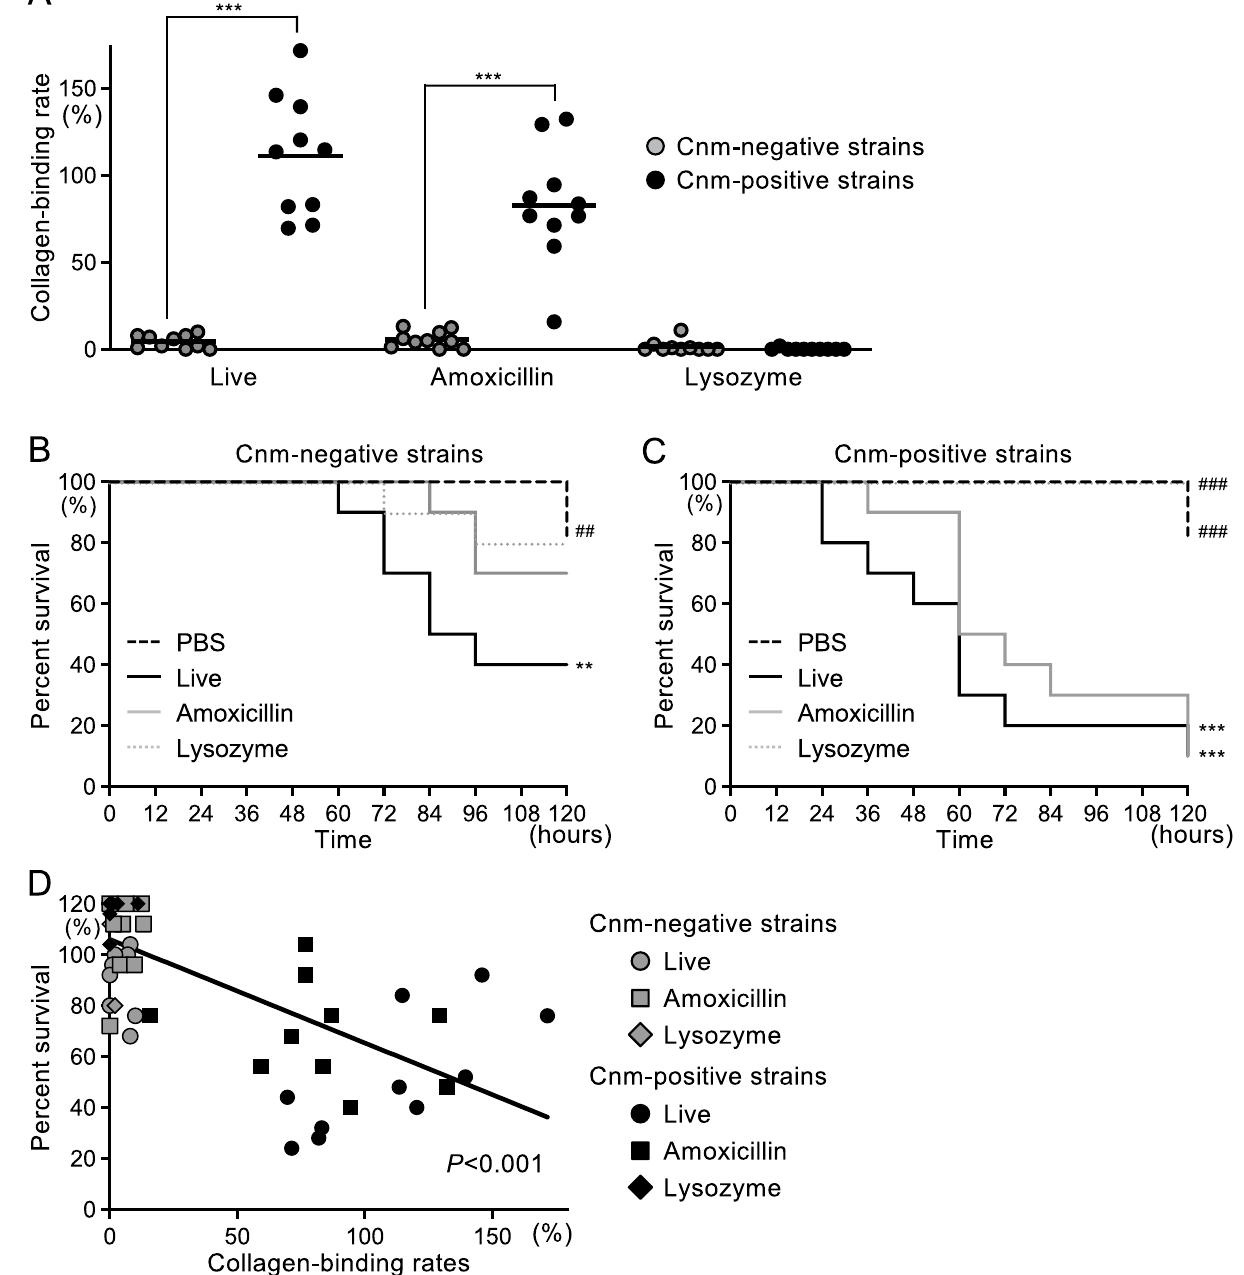
Figure 6. Collagen-binding properties and survival curve for silkworm larvae induced by live S. mutans clinical isolates and killed S. mutans clinical isolates (treated with amoxicillin or lysozyme). ( A ) Collagen-binding rates of S. mutans strains. Each closed circle represents the mean value for each bacterial strain. Significant differences were observed using analysis of variance with Bonferroni correction (*** P < 0.001). Silkworm larvae infected with ( B ) Cnm-negative clinical isolates, and ( C ) Cnm-positive clinical isolates. Survival rates in each group were evaluated in a Kaplan–Meier plot, which was analyzed by a log-rank test. ** P < 0.01 and *** P < 0.001 versus phosphate-buffered saline group; ## P < 0.01 and ### P < 0.001 versus live S. mutans administration group. ( D ) Correlation between collagen-binding rates and survival rates of silkworms analyzed by regression analysis. Each point represents the mean value for each bacterial